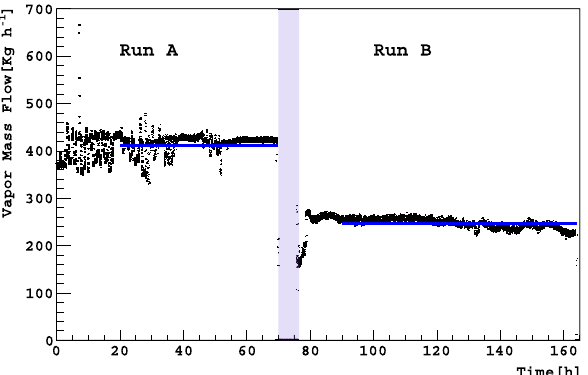
Fig. 13 Measuredvapormassflowintheauxiliarysystemdownstream of the compressor vs time, for 29 N 2 – 28 N 2 distillation in the prototype plant.Theverticalcyanbandrepresentsthetimeduringwhichtherotary pump compressor was switched off. The horizontal blue lines represent the average values over Run A and Run B, taken only for time periods after the distillation transients of both runs are over, as observed in Fig. 16. They correspond to 412kgh − 1 and 247kgh − 1 , respectively